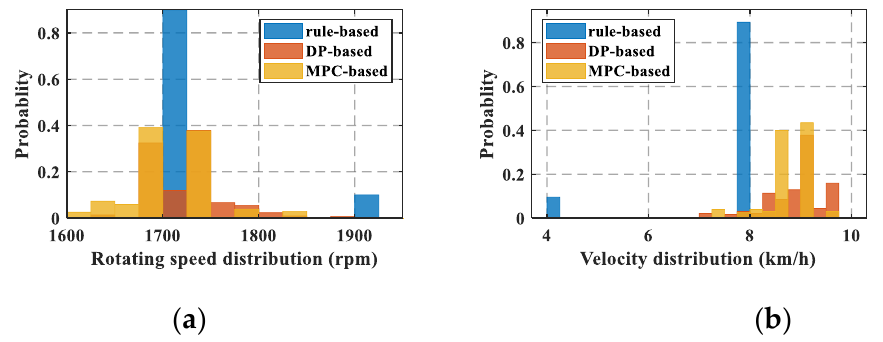
Figure 28. Distribution of the control variables: ( a ) rotating speed of the working motor and ( b ) velocity of the vehicle.